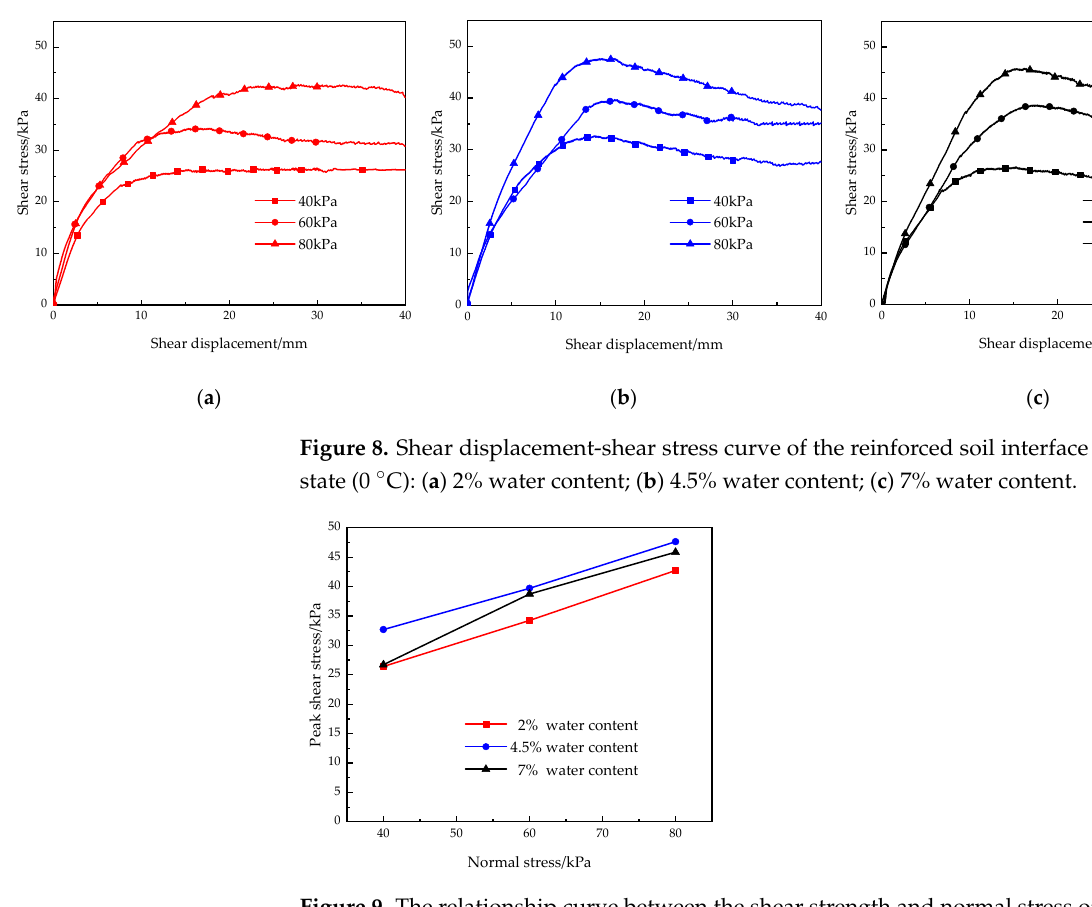
Figure 10. The influence of water content on the peak shear stress of the reinforced soil interface under the nonfreezing state (0 °C). 3.2. Freezing State ( − 5 °C) Reinforced Soil Interface Characteristics Figure 11 shows the shear displacement ‒ shear stress curve of the interface between the geogrid and coarse-grained soil with different water contents under the freezing state ( − 5 °C). The curve is basically the same as the trend of the interface shear displacement ‒ shear stress curve in Section 3.1. There is no obvious brittle shear failure of soil with de- creasing freezing temperature [26–29]. The author considers analyzing from two aspects. First, the soil sample used in this experiment is coarse-grained soil, which is different from the clay or fine-grained soil used by some scholars. Frozen soil is composed of soil parti- cles, unfrozen water, pore ice and air. The unfrozen water content and pore ice play a major role in the shear strength of reinforced soil composites. Compared with frozen clay and frozen fine-grained soil, the soil samples with more coarse-grained content have larger soil skeleton pores, and there is still a considerable amount of unfrozen water in the negative temperature state, which leads to obvious plastic deformation. The pores of fine- grained soil and clay are small. With the increase in compactness, the interaction between the soil and pore ice is obvious. The cementing force of ice enables the surrounding soil to be more compactly bonded together, increasing the cohesion of the soil. Second, the size of the direct shear box used in this experiment is 490×500×300 mm (L×W×H). According to Figure 11, the larger direct shear box does not obviously reflect the difference in the failure mode of the reinforced soil interface at different temperatures. The size effect will affect the shear behavior of the reinforced soil interface, but it decreases with the increase in the size of the test model [30,31]. Therefore, the temperature variable in the direct shear between the geogrid and coarse-grained interface has little effect on the trend of the stress curve but more on the shear strength.